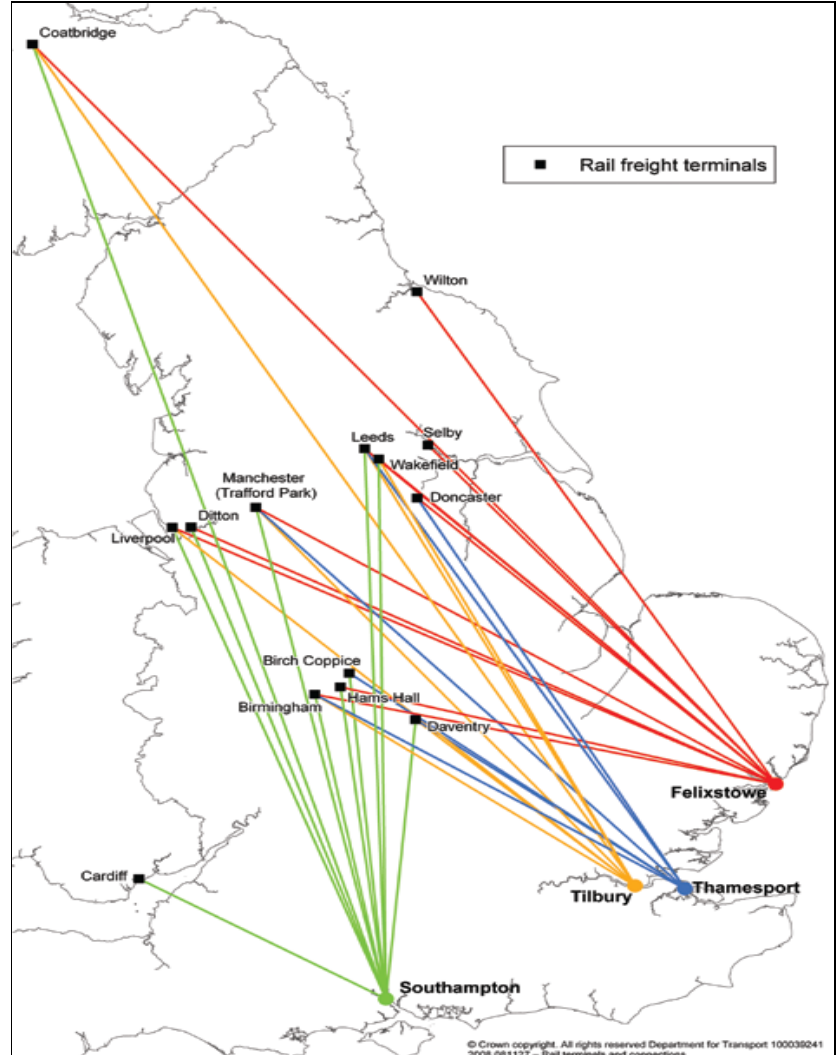
Figure 1. Indicative map of rail services to/from the four key container ports Source: DfT (2008), based on author’s